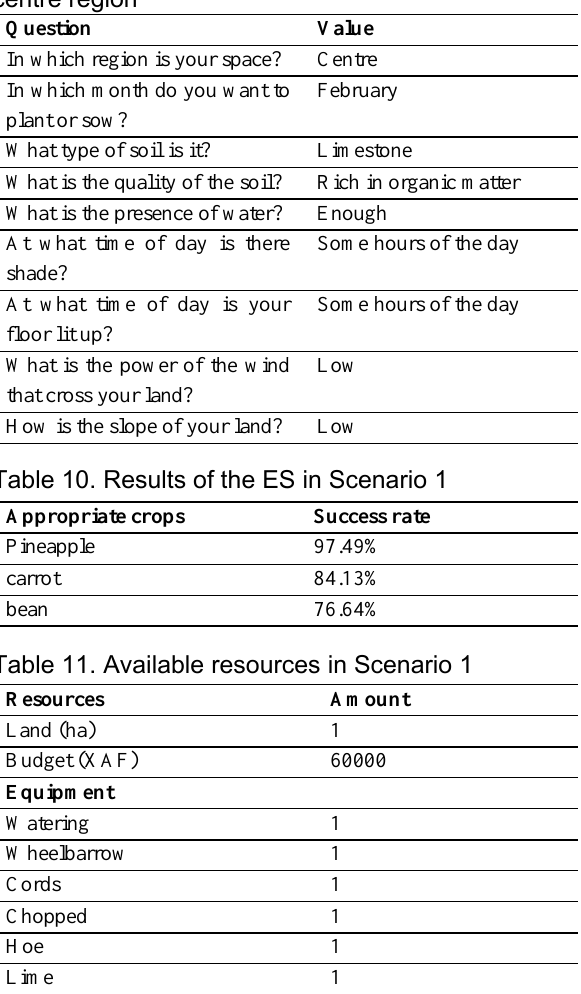
Table 9. Favourable conditions for pineapple in the